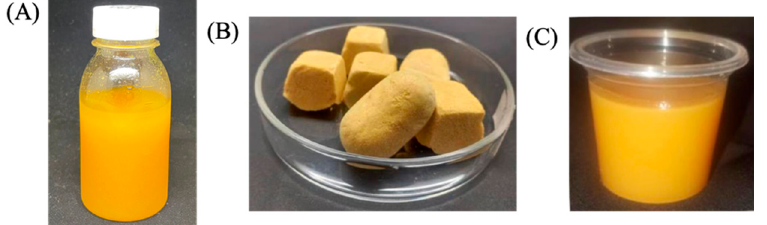
Figure 1. Appearance of HHP-treated blended juices and HHP–VFD-treated blended cubes. ( A ) HHP3 sample (blended juice treated with HHP at 600 MPa). ( B ) HHP3–VFD sample (blended cube of HHP3 juice treated after VFD). ( C ) Rehydrated HHP3–VFD juice.